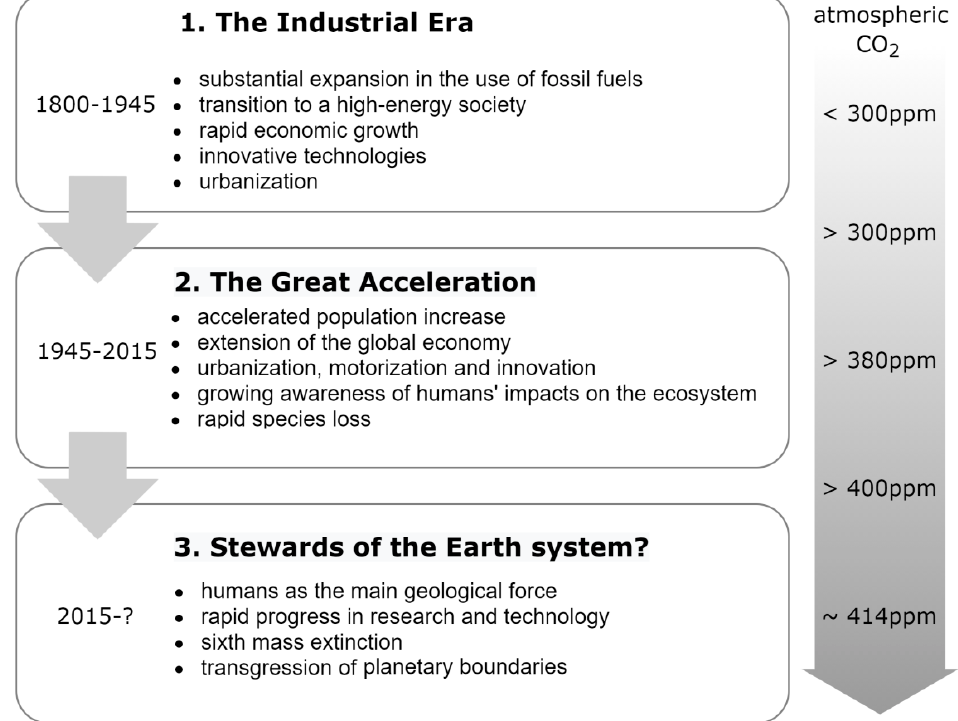
Figure 1. The stages of the Anthropocene [7]. The trajectory of stage 3 where humankind become aware and mitigates anthropogenic impacts upon Earth systems (termed as the ‘Stewards of the Earth System’ stage) is presently unclear [10]. Atmospheric CO 2 levels that have increased through the stages are presented (values cited from National Oceanic and Atmospheric Administration (NOAA) [9].